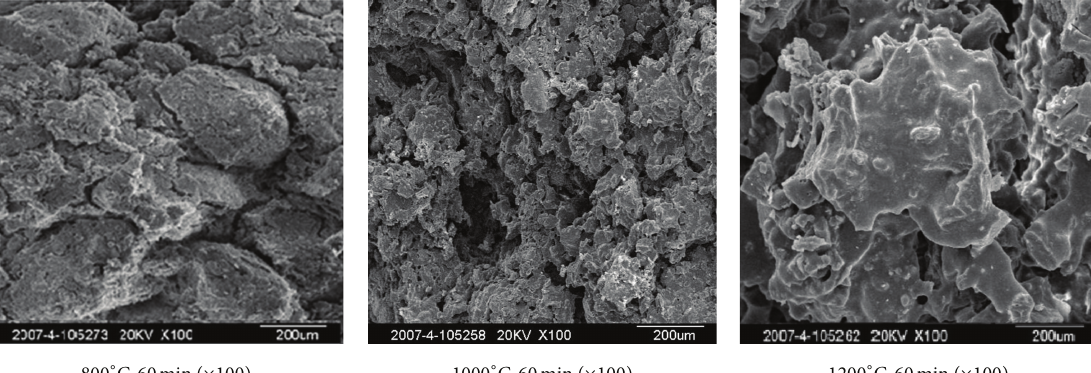
Figure 7: SEM of sintered products at different sintering